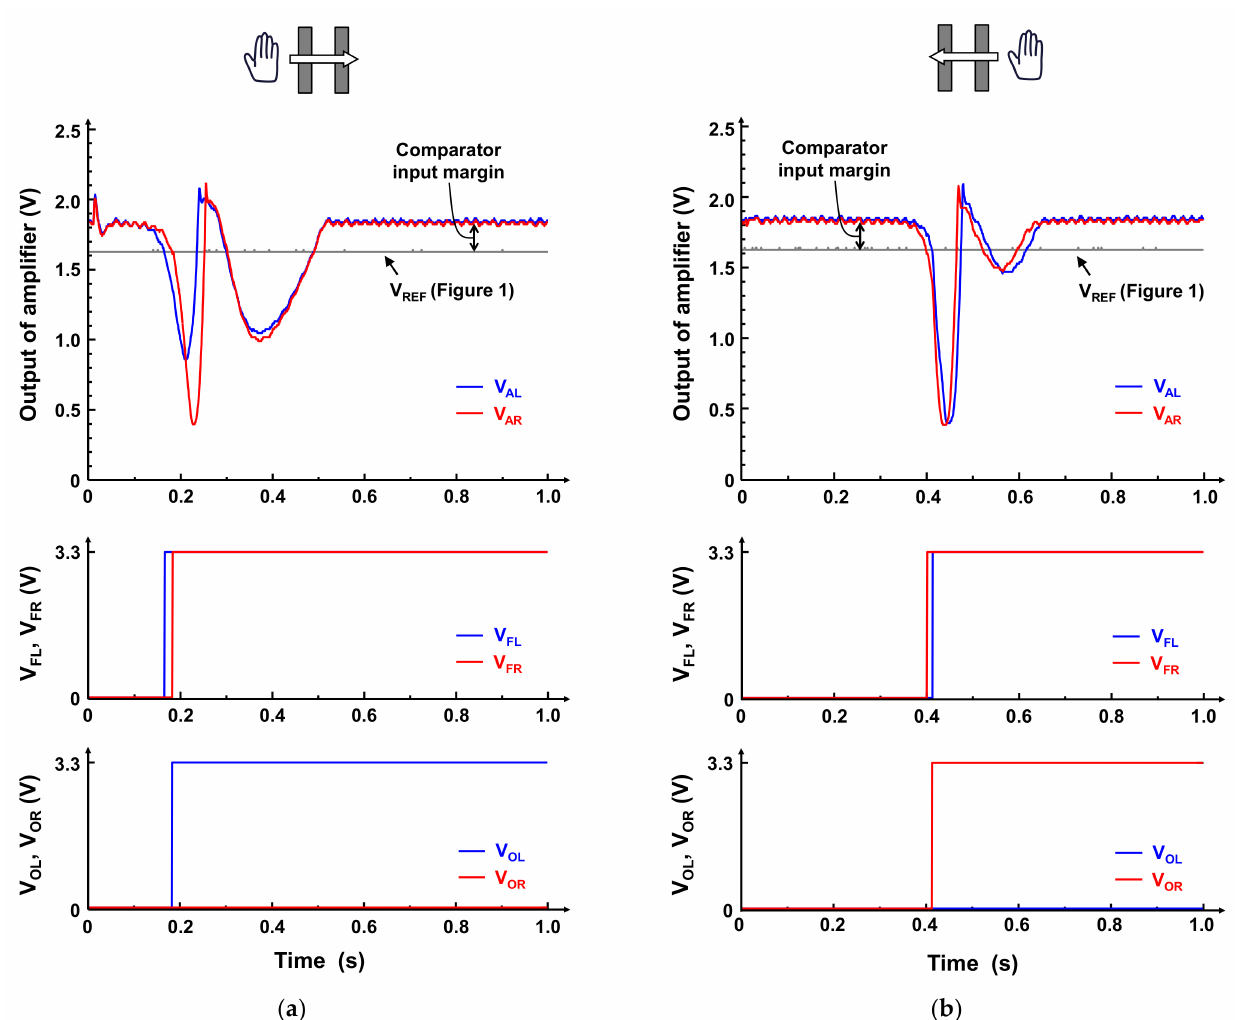
Figure 11. Measured waveforms when the hand moves horizontally on the electrode with a distance of 5 cm between the hand and the electrode ( a ) from left to right and ( b ) from right to left. V AL and V AR denote the amplified signals (V A in Figure 1) input from left and right electrodes, respectively. V FL and V FR are latched output of the comparator, and V OL and V OR is the outputs of the proposed gesture recognition chip, as shown in Figure 1. By observing V OL and V OR , the gestures, such as the hand movement from left to right (V OL goes high) and from right to left (V OR goes high), can be